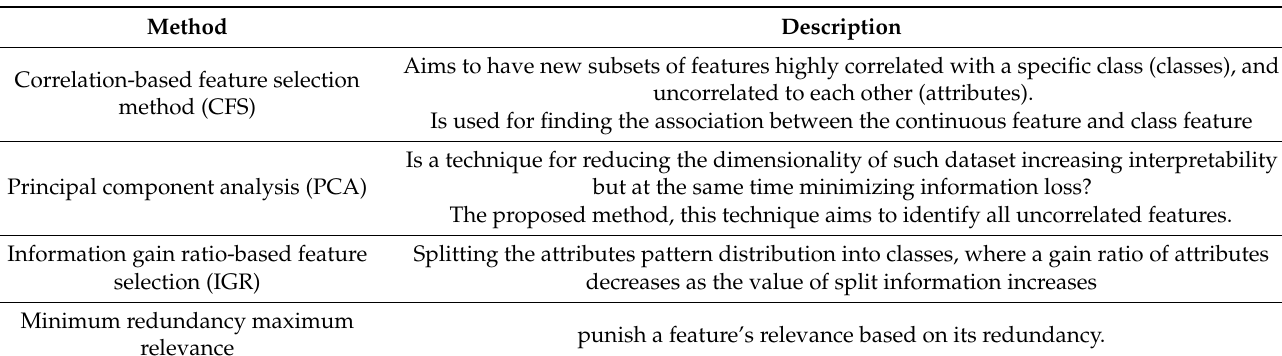
Table 3. The feature selection methods in dataset